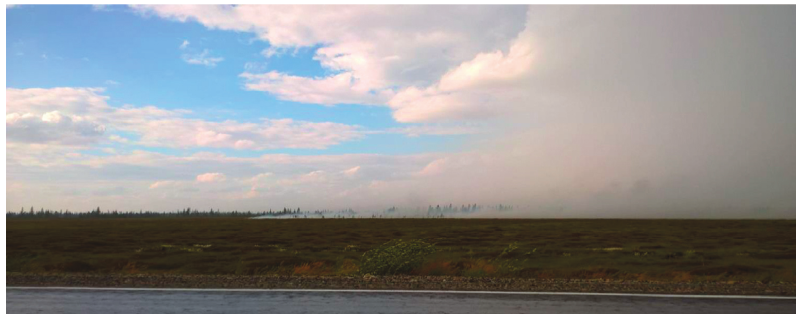
Figure 2: Surface fire in forest-tundra landscape, surroundings of the Pangody